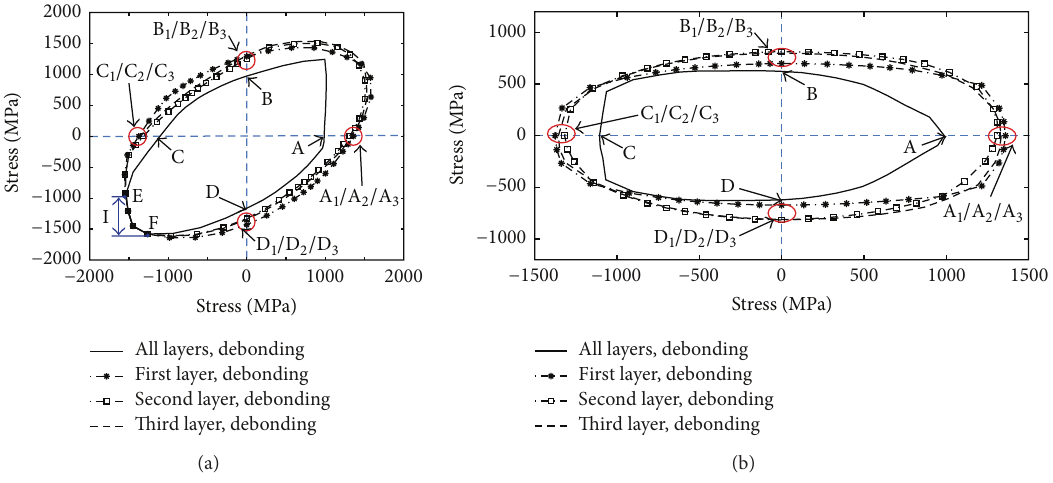
Figure 5: The failure envelopes of [0/ ± 45/90]